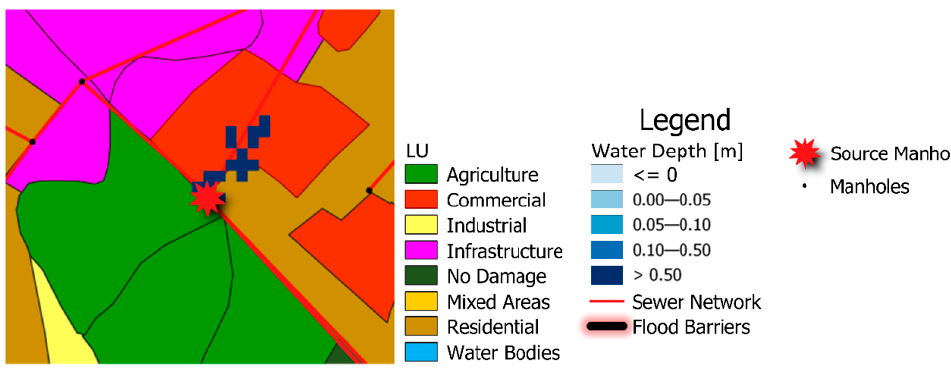
Figure 9. Final flood extents propagation in GAMA for manhole “38B140” of a design storm event with 100-year return period.